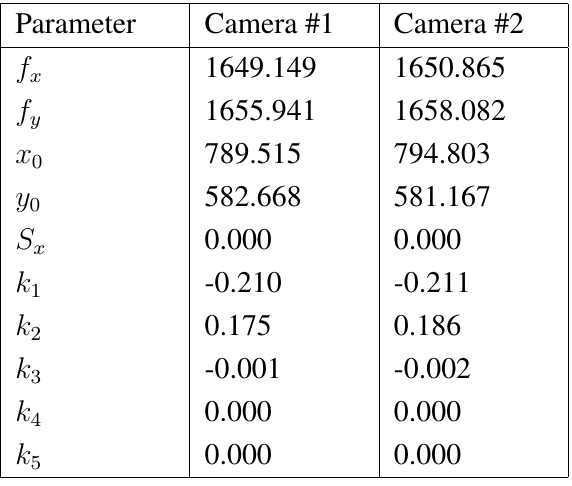
Table 2. The camera calibration parameters of the test